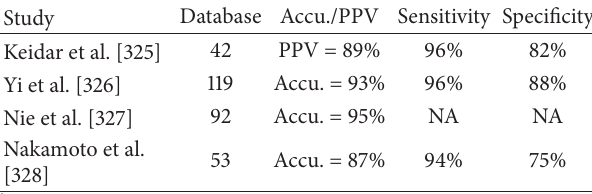
Table 11: Evaluation of nodule malignancy in fused